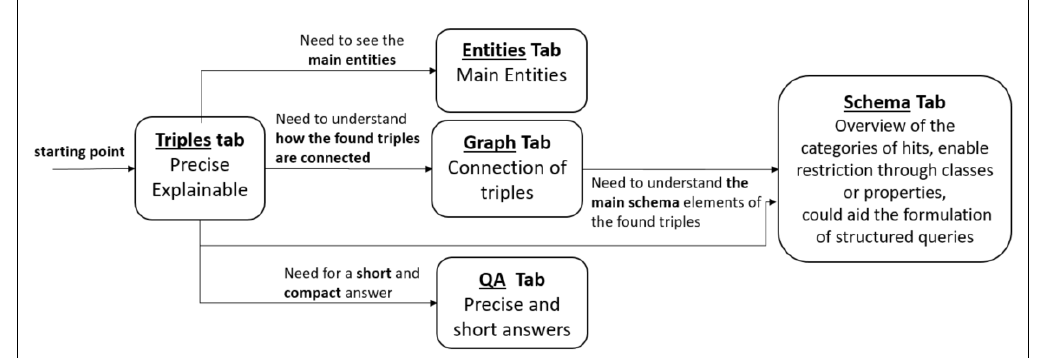
Figure 4. The Added Value of each Perspective.